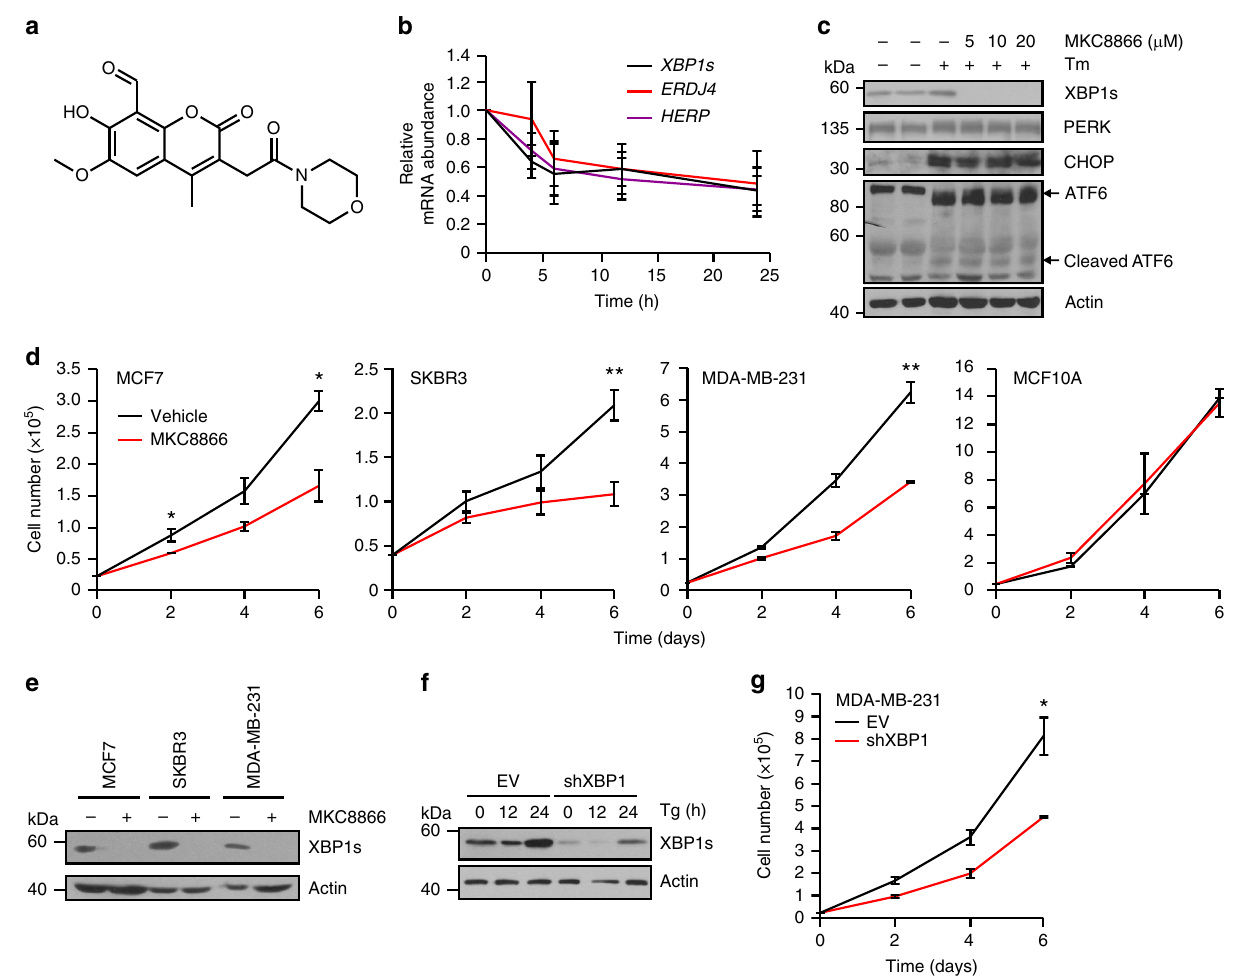
Fig. 2 Inhibition of IRE1 reduces breast cancer cell proliferation. a Chemical structure of MKC8866. b MDA-MB-231 cells were treated with 20 μ M MKC8866 for 4, 6, 12, and 24 h after which RNA was extracted and levels of XBP1s , ERDJ4 , and HERP mRNA transcripts quanti fi ed by Q-PCR ( n = 4). c T47D cells were treated for 24 h with 1 μ g ml − 1 Tm alone or in combination with increasing concentrations of MKC8866 (5, 10, 20 μ M) and cell lysates immunoblotted for XBP1s, PERK, CHOP, ATF6, and Actin. d MCF7 ( n = 3), SKBR3 ( n = 5), MDA-MB-231 ( n = 2), and MCF10A ( n = 3) cells were treated with 20 μ M MKC8866 or an equal volume of DMSO and cell proliferation monitored by cell counts every second day for 6 days. e MCF7, SKBR3, and MDA-MB-231 cells were treated with 20 μ M MKC8866 for 24 h and cell lysates immunoblotted for XBP1s and Actin. f Empty vector (EV) and XBP1shRNA MDA-MB-231 cells were treated for the indicated times with Tg (0.5 μ M) after which expression of XBP1s and Actin was determined by immunoblotting. g Proliferation of empty vector (EV) and XBP1shRNA MDA-MB-231 cells was monitored by cell counts every second day for 6 days ( n = 3). Results shown for c , e, and f are representative of three independent experiments. * P < 0.05, ** P < 0.01 and *** P < 0.001, based on a Student ’ s t test. Error bars represent (Supplementary Fig. 4e). Since TGF β 2 regulation upon IRE1 knockdown differed to the results obtained with MKC8866, we